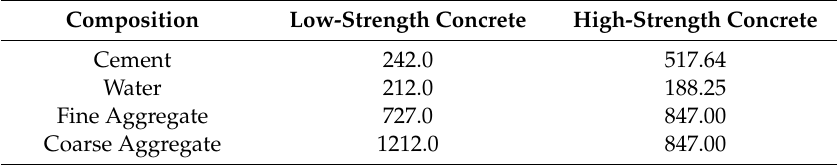
Table 2. Concrete mix proportion (kg per cubic meter).